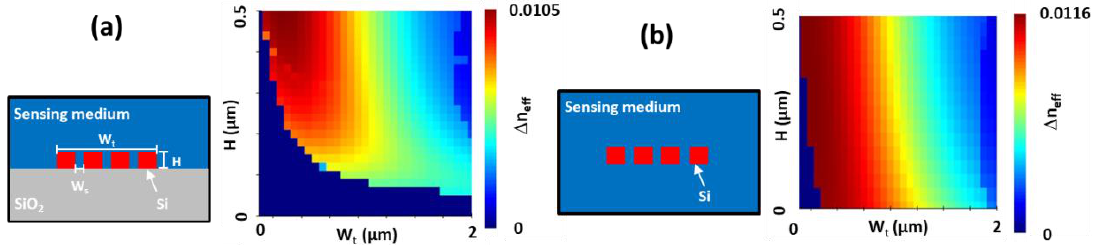
Figure 3. Mapping of ∆ n eff for ( a ) non-suspended and ( b ) suspended Si MS-WGs depending on W t and H with W s = 60 nm and SC = 3.